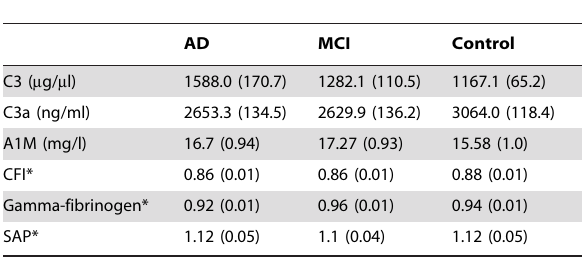
Table 2. Plasma concentrations of assayed candidate biomarkers with their corresponding standard errors.